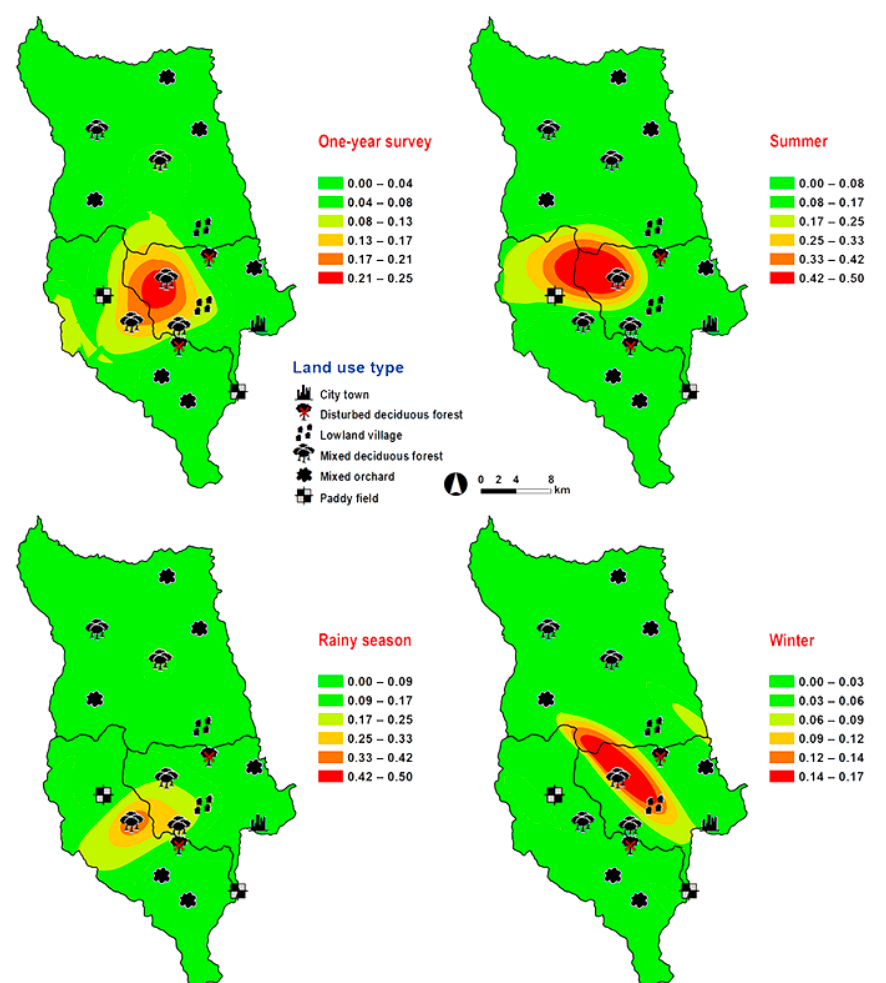
Figure 7. Predictive distribution maps of Lucilia papuensis. The color scheme represented different fly density categories. The red areas represent the highest fly population, while the green represent the lowest population density. The scale corresponds to natural logarithm of (fly density + 1).